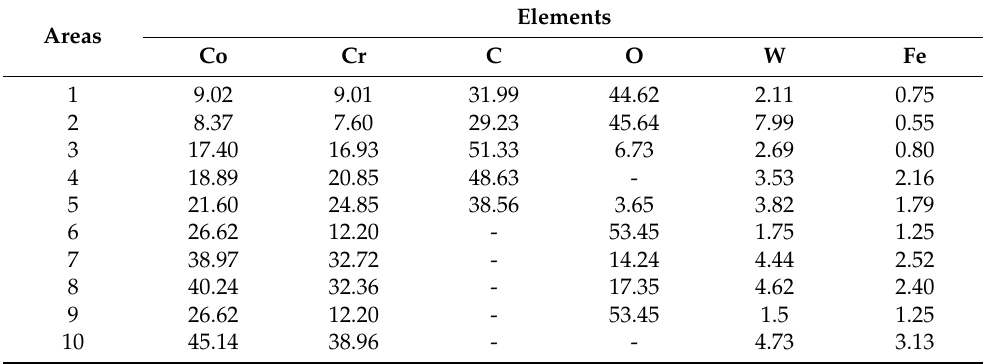
Table 5. EDS results of the corresponding region of Stellite 20 coating wear morphology (at%).